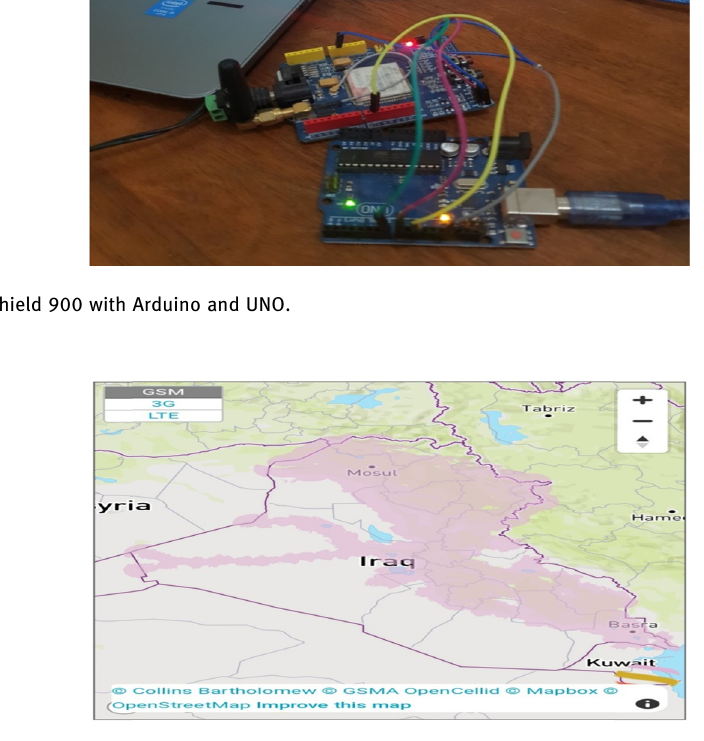
Figure 8: Map one of the mobile phone network operator in